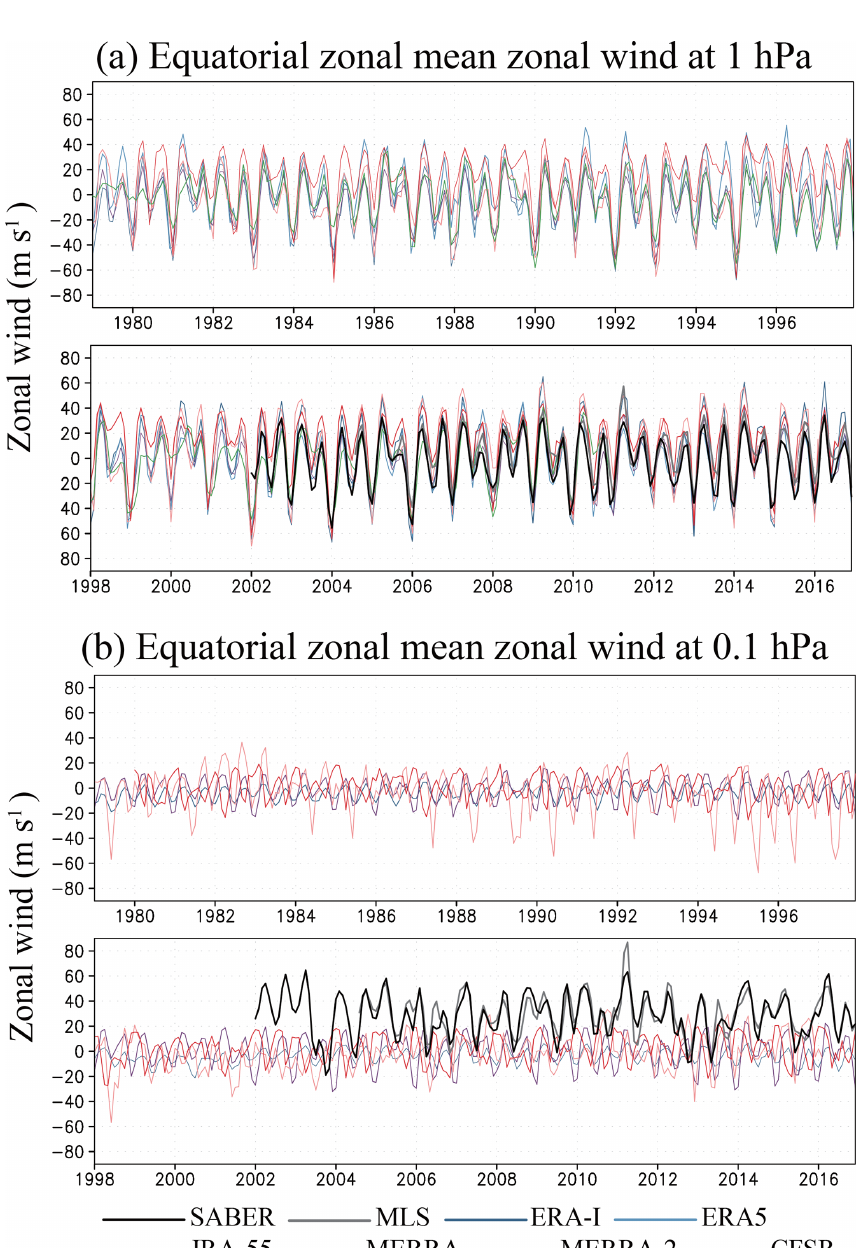
Figure 3. (a, b) Time variations of the equatorial zonal wind at (a) 1hPa and (b) 0.1hPa for SABER, MLS, and each